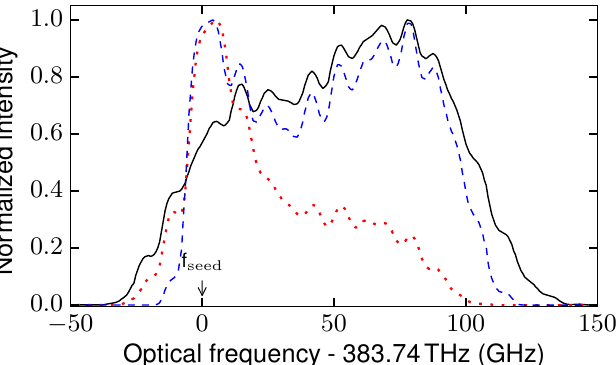
Figure 2: Optical spectrum of the FSF laser measured with the grating spectrometer without external seed (solid black) and an external seed power of 460 µ W (dashed blue) and 720 µ W (dotted